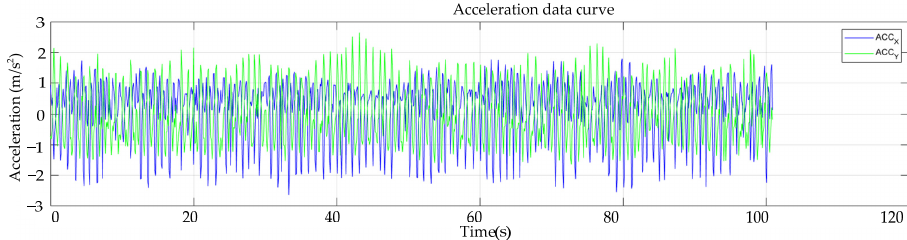
Figure 14. x -axis and y -axis acceleration data curve.